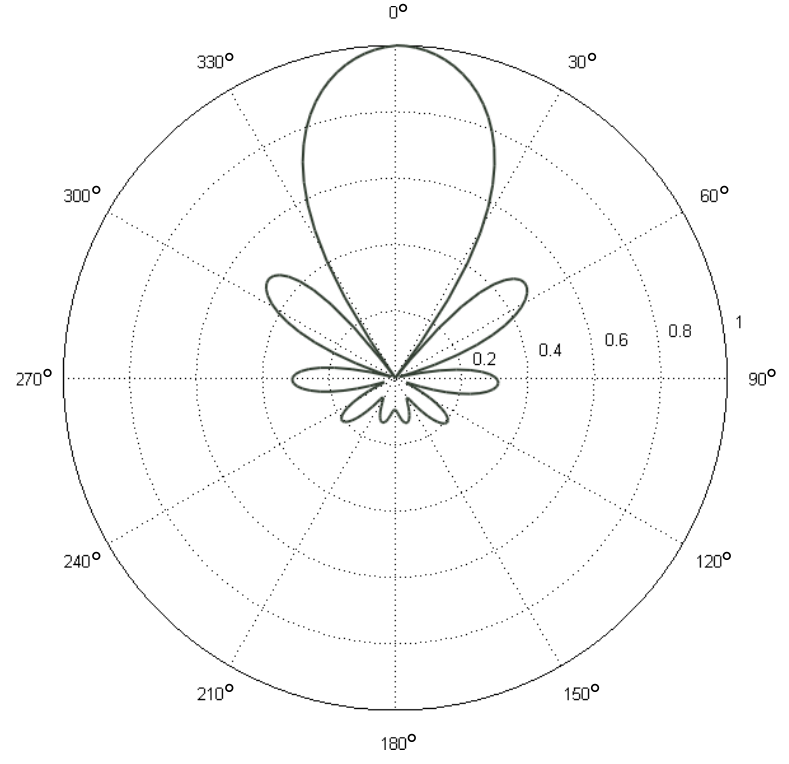
Figure 5. Rough conceptual drawing of the directivity pattern of an ultrasonic speaker element. The beam sizes present the proportion of sound emitted in different